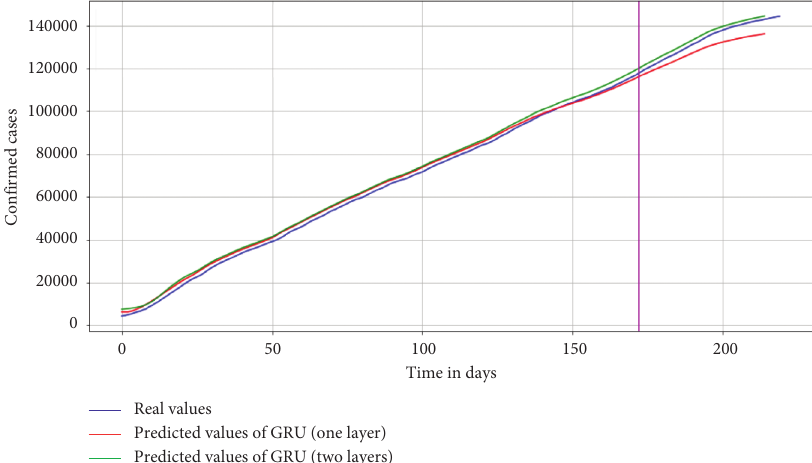
Figure 11: Comparison between real confirmed cases and the predicted confirmed cases for GRU